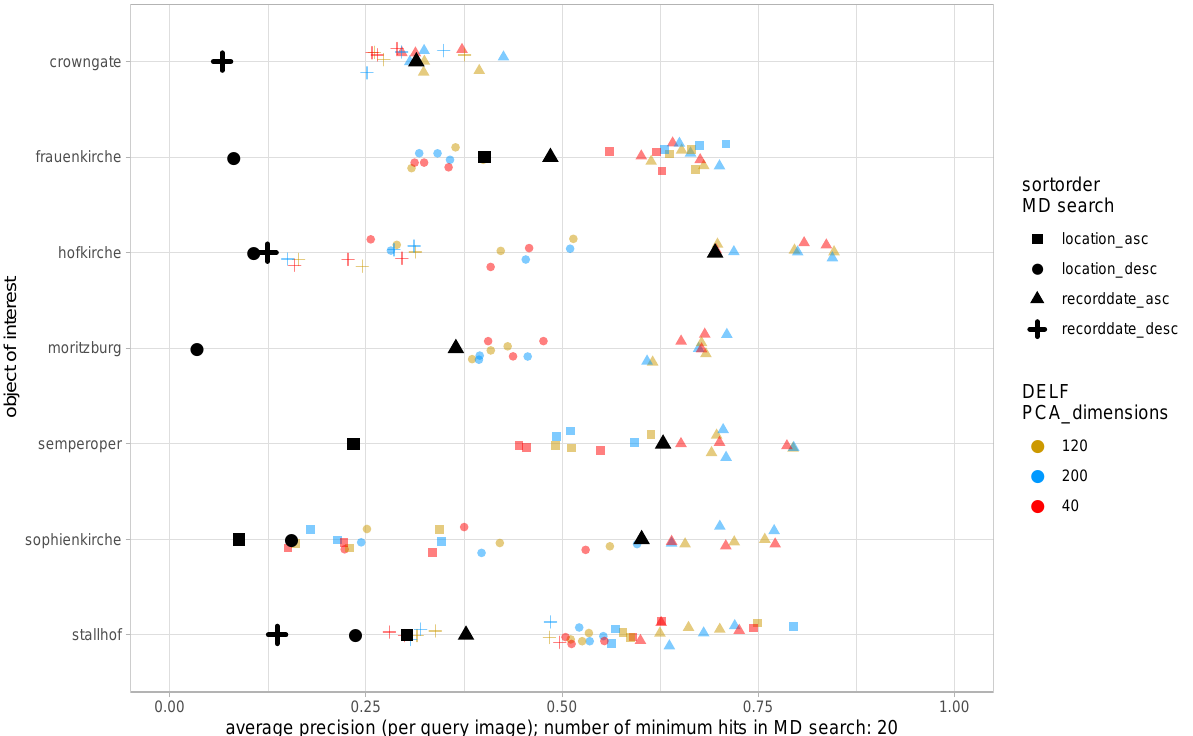
Figure 4. Average precision for MD search and DELF IR over all seven